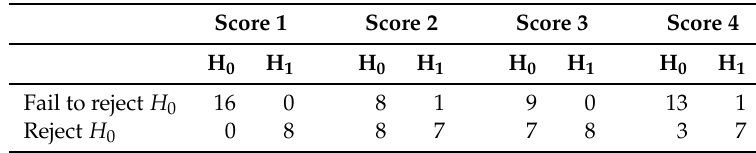
Table 6. Categorization of the samples with respect to the presence or absence of a fault and the result of the test for each of the four scores when the size of the samples to diagnose is ν = 50 and the sensors used are numbers 1,2,4,5,6 and 7.